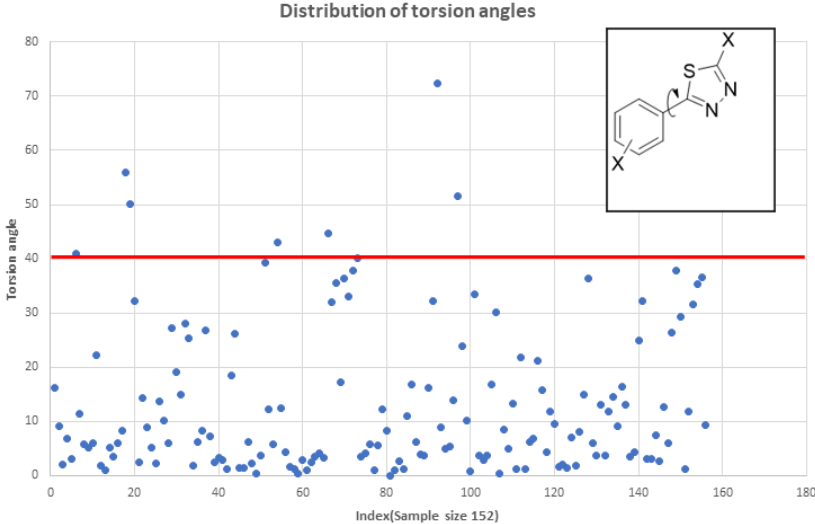
Figure 9. Distribution of torsion angles based on 152 CSD-reported 1,3,4-thiadiazol structures. Atom-to-atom replacement of halogen atoms resulted in a more significant enhance- ment of the electrostatic potentials compared to those noted in the case of the chalcogen replacement. Despite this difference, only 3/5 structures contained noteworthy halogen bonds, whereas chalcogen bonds were present in all five crystal structures examined herein. Only one of the two bromine-based compounds formed halogen bonds, whereas the iodine compounds showed Type II halogen bond formation in 2/5 structures, Scheme 2. All iodine-containing structures not undergoing halogen bonding show that despite the predictability of the MEPs, it was not always perfect; however, in general, the increased structural influence can be attributed to larger σ -hole potentials of the more polarizable iodine atom. The lack of halogen bonds in previously reported fluorine [38] and chlorine [39] analogs further validates the expectation that a more polarizable halogen atom is more likely to influence the solid-state assembly in ways to go beyond simple (and less directional) packing forces. Scheme 2. Summary of notable intermolecular interactions in the crystal structures examined herein. sHB: Single Hydro- gen Bond. sChB: Single Chalcogen Bond. bChB: Bifurcated Chalcogen Bond. A comparison of the frequency of occurrence of hydrogen, halogen, and chalcogen bonds in the crystal structures of these 1,3,4-chalcogendiazole shows that the former was the most prominent; hydrogen bonding exists in all of them and 4/5 exist as hydrogen bond dimers and 5/5 as single hydrogen bond formation. The significance of the hydrogen bonding and the delicate balance between the hydrogen, halogen, and chalcogen bonding was clearly displayed in the two polymorphic structures. The melting points of Form I